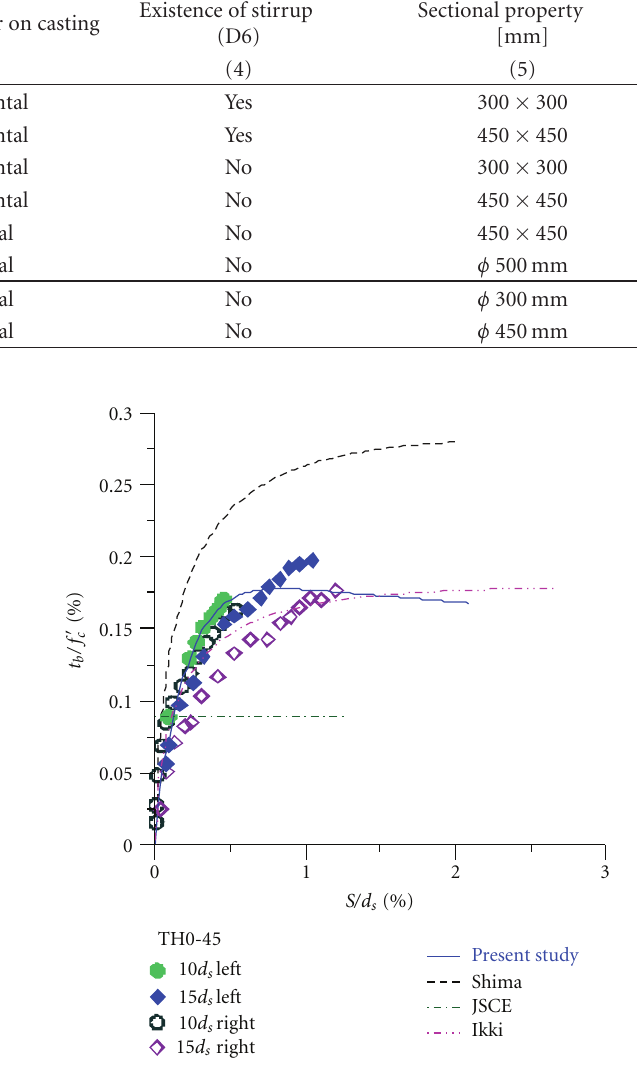
Figure 10: Bond stress-slip relationship of TH0-45